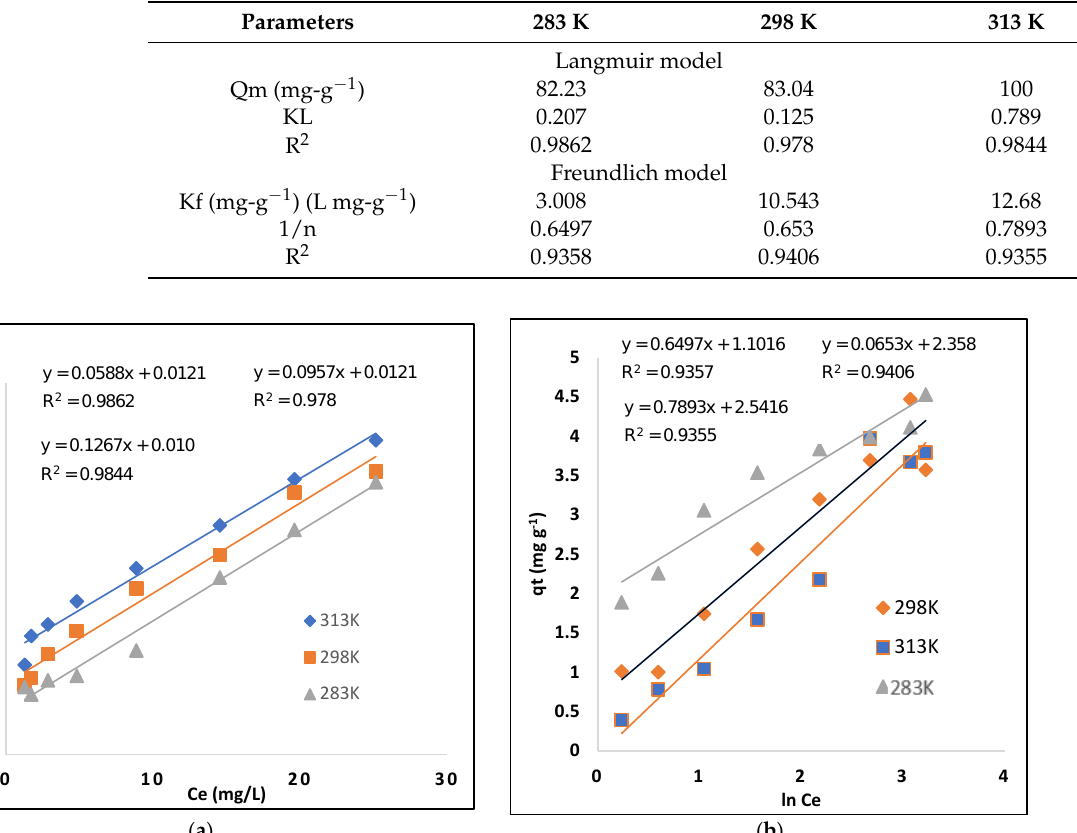
Figure 7. Isotherm models: ( a ) Langmuir and ( b ) Freundlich.